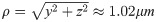
Gradient Sharpening Due to Steric Effects.We plot the pheromone concentration as a function of x, with ρ=y2+z2≈1.02μm. The red curve is calculated from our simulations, which include binding and unbinding reactions. The dashed, black line is the ideal, linear concentration profile. (A) Results from eight simulations in which pheromone molecules reflect off the cell surface. There is no pheromone in the cell interior (x = –2.28μm to x = 2.28μm). (B) Same as (A), except that the reflecting cell boundary has been removed. That is, pheromone molecules can diffuse through the cell membrane, but are still able to bind receptors. (C) Histograms from the simulation results shown in (A). The blue and red histograms show the distributions for the number of active receptors, Ste2*, located in the back and front half of the cell, respectively. The solid vertical lines indicate the mean for their respective distributions. The dashed curves indicate the theoretical distribution for a cell in a linear gradient. (D) Same as (C) using data from simulations in (B), that is, with a permeable cell membrane.